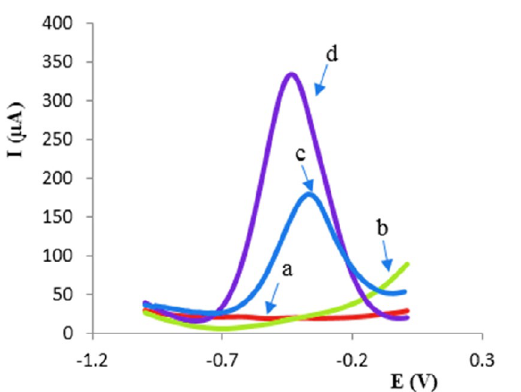
Fig. 2 Fig. 2. DPVs of carbon paste electrode in blank (a), Zn Fe O /CPE in 0.9 µg 0.5 0.5 2 4